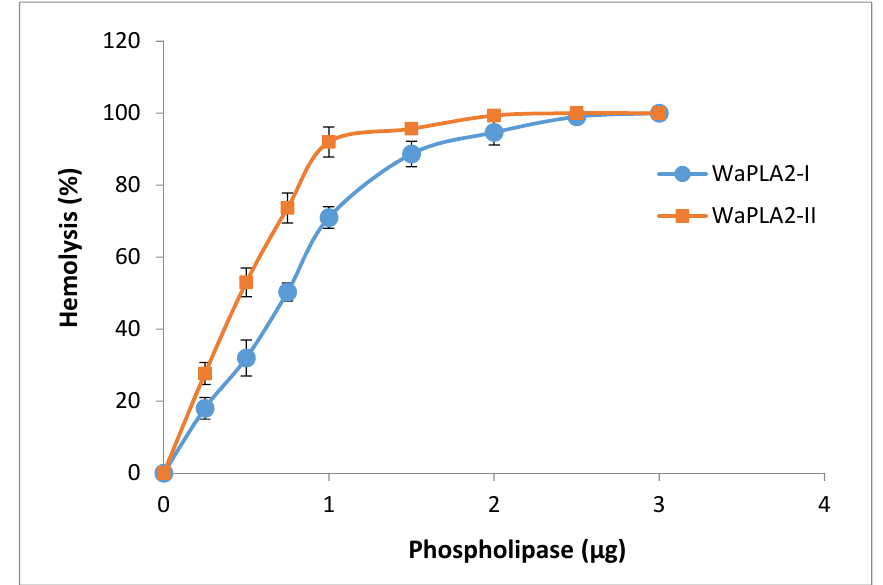
Figure 7. Dose-dependent indirect hemolytic activity of Wa PLA 2 -II and -I. The two purified enzymes (0–3 μ g) were incubated at 37 °C for 10 min with PC, RBCs, and PBS (1:1:8 v/v ) to release hemoglobin. Free hemoglobin was then determined by measuring the absorbance at 540 nm. The results represent the means of three independent experiments and expressed as the mean ± SD (n = 3).